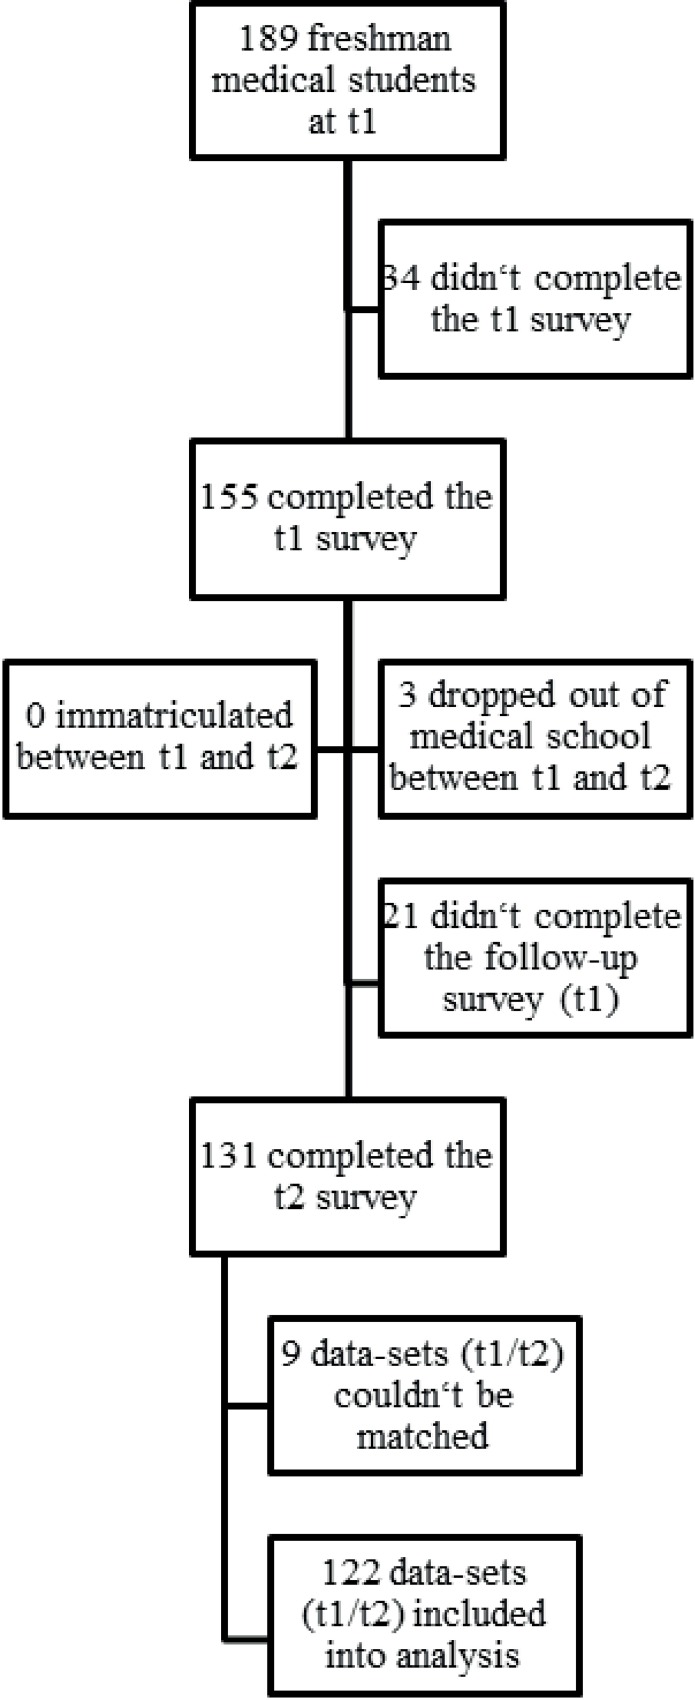
Participant flow.